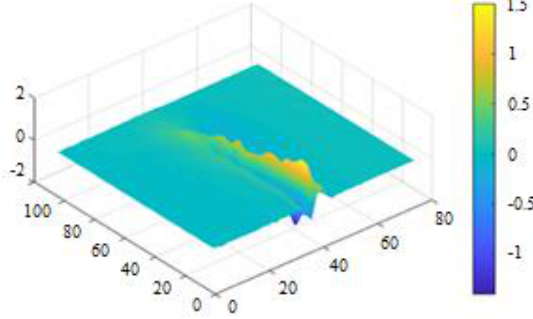
Figure 11. 2D grid coordinates of segmented image.